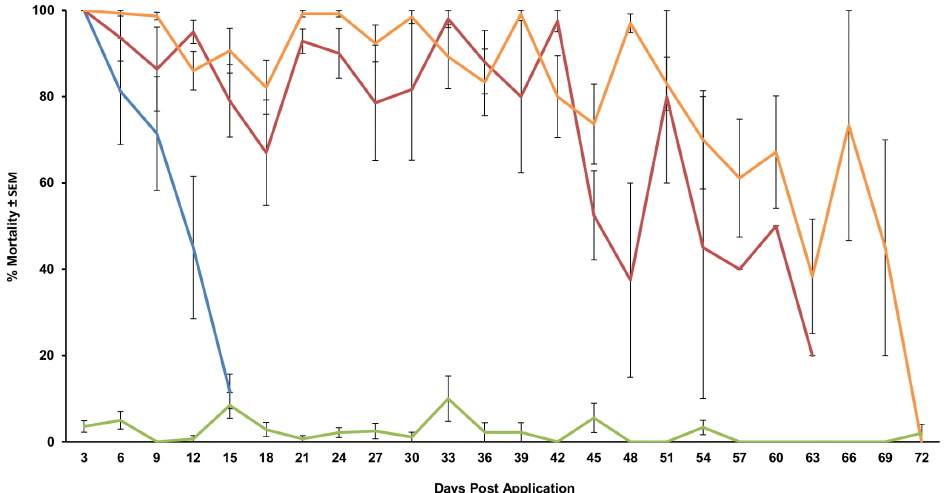
Figure 5. Residual efficacy of VectoBac WDG applied with a CSM2 and LV-8 at 400 and 800 g/ha in residential areas. Orange and red=CSM2 at 800 g/ha, blue=LV-8 at 400 g/ha,